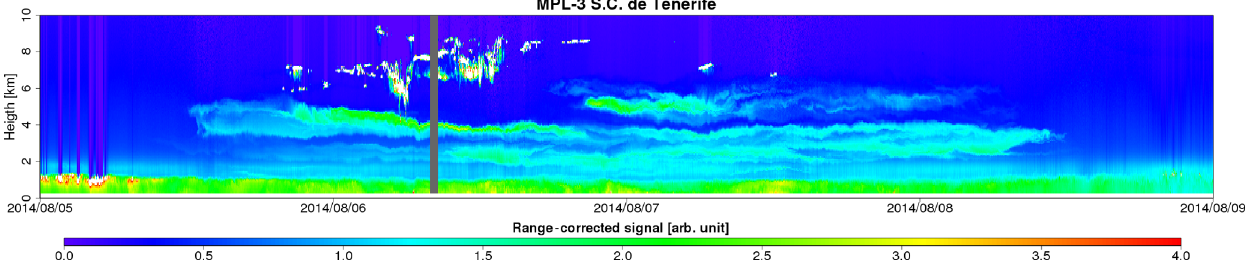
Figure 1. Range-corrected signal mapping of a dust intrusion over the island of Tenerife on August 2014. In this case, the dust layer is well separated from the marine layer.